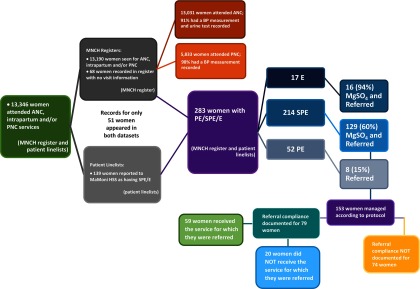
Client Flow ChartAbbreviation: ANC, antenatal care; BP, blood pressure; HSS, Health Systems Strengthening; MgSO4, magnesium sulfate; MNCH, maternal, newborn, and child health; PE/SPE/E, preeclampsia, severe preeclampsia, or eclampsia; PNC, postnatal care.